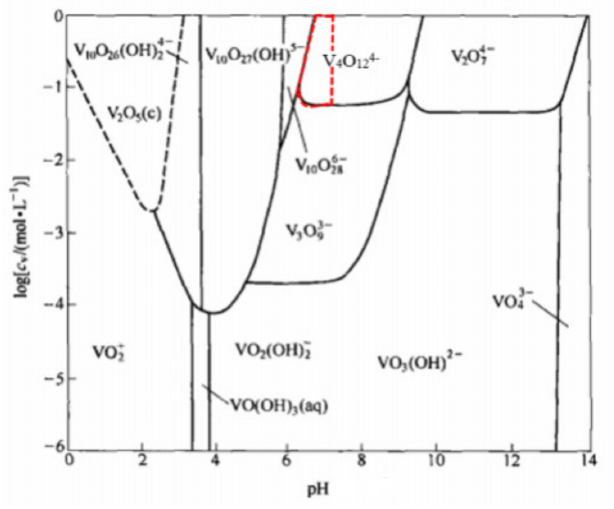
Figure 8. Morphology of pentavalent vanadate ions in aqueous